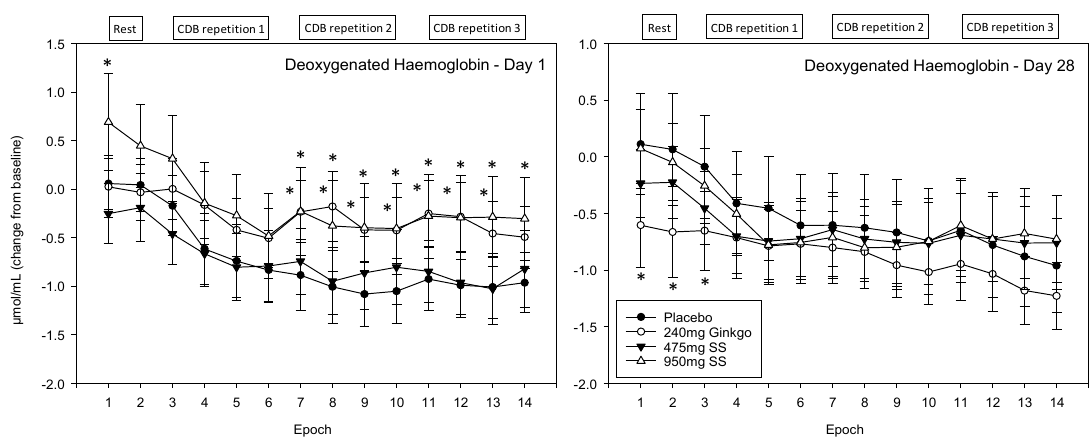
Figure 11. Acute and chronic effects of treatment on deoxygenated haemoglobin concentrations. Mean (±SEM) deoxygenated haemoglobin concentrations during 5 min of rest (averaged into 2 × 2.5 min epochs) and 30 min (three repetitions) of the cognitive demand battery (CDB). Each 10 min CDB comprises 1 × 2 min epoch of serial 3 and 1 × 2 min epoch of serial 7 subtractions and 2 × 2.5 min epochs of Rapid Visual Information Processing (RVIP). ( left ) Deoxygenated haemoglobin changes on Day 1; and ( right ) deoxygenated haemoglobin changes following 28 days of supplementation with 475 mg Sideritis scardica (SS), 950 mg SS, active control (240 mg Ginkgo biloba ) or placebo control. Data on both days were recorded during a ~150–240 min post-dose period and converted from the pre-dose baseline on Day 1. * = p < 0.05.